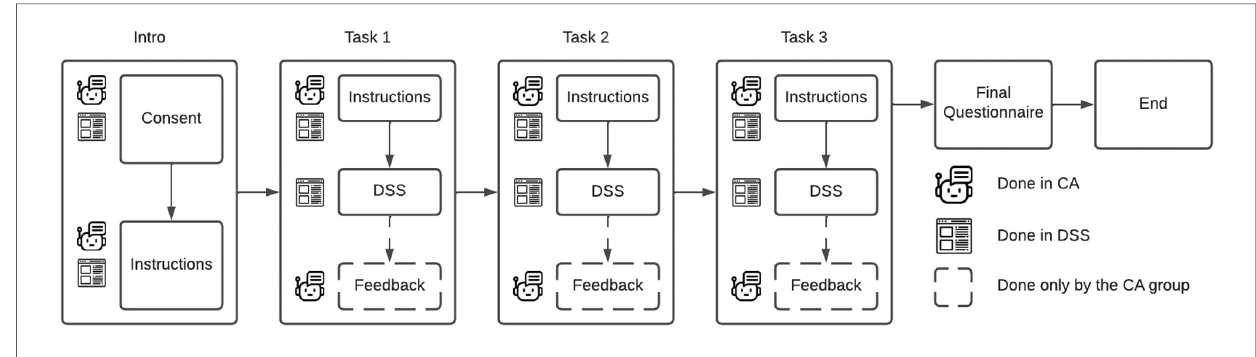
FIGURE 2 Flow diagram of the study design for the two study groups. The WEB group does every part of the study in the DSS, while the CB group switches from the chatbot to embedded DSS only for task completion. The chatbot brie fl y asks, what methods the user found from the CB